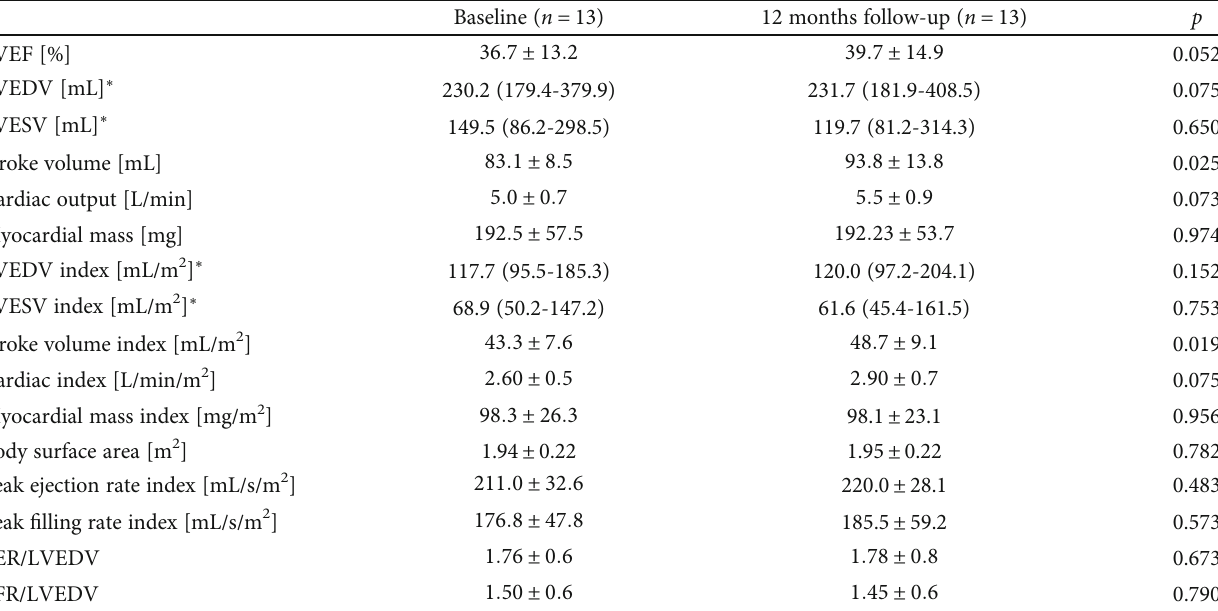
Table 2: Left ventricle functional assessment by cardiac magnetic resonance.